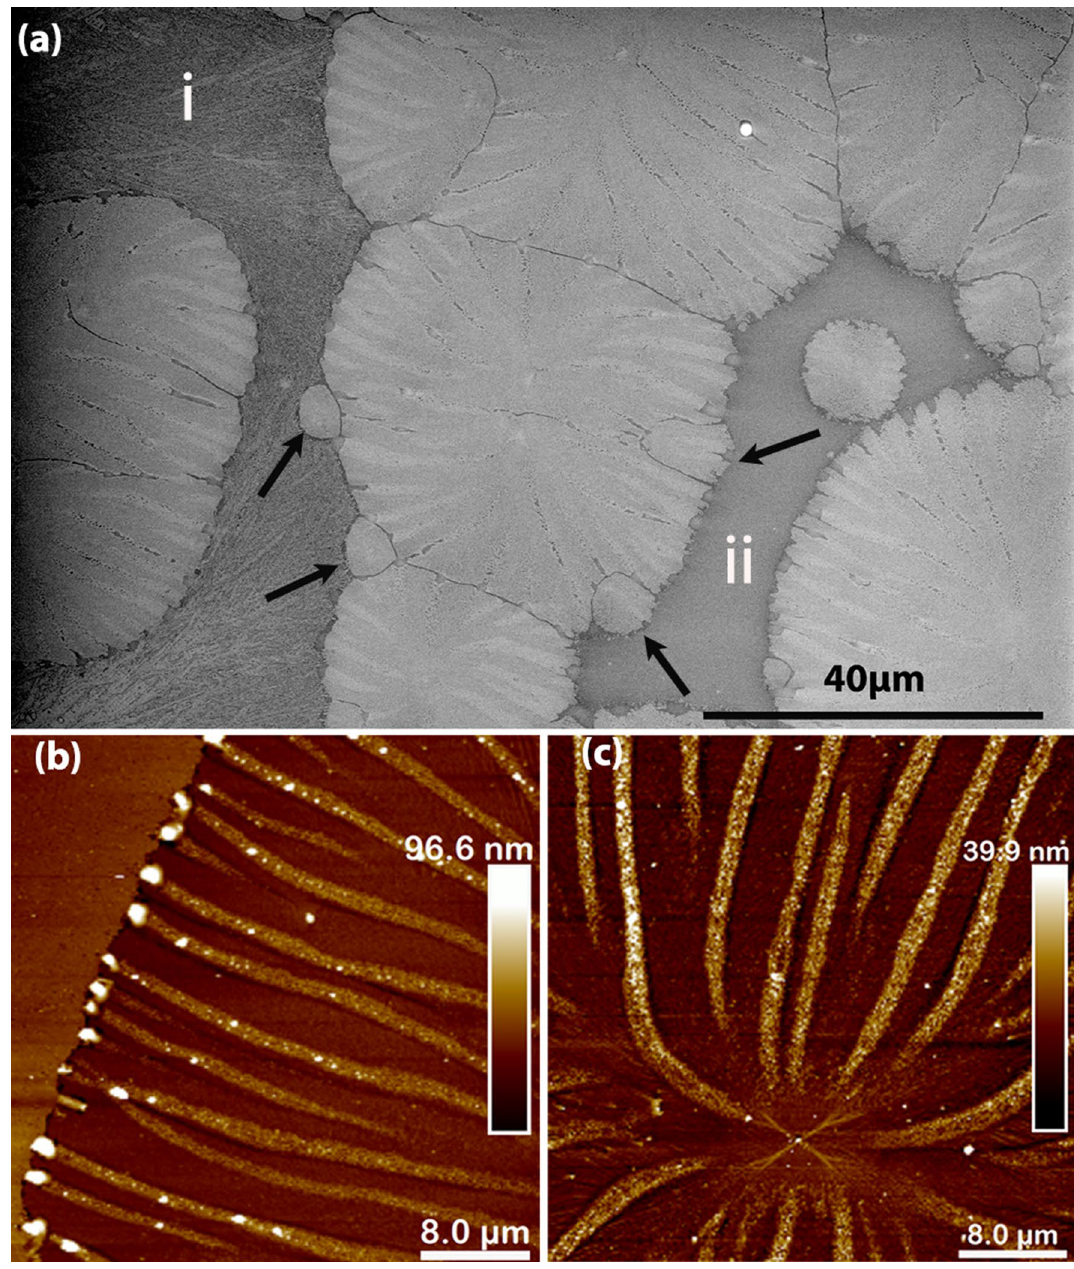
Figure 5. ( a ) SEM images of a Si 0.75 Ge 0.25 O 2 film grown on Y-cut quartz substrate shows the crystallization of domains surrounded by low crystallinity areas (i) and amorphous areas (ii). The black arrows point to the new domains nucleated at the edge of a bigger domain. ( b ) AFM image of a domain boundary where bumps are formed when the stripes meet the boundary. Notice the stripes are about 10 nm higher than the areas in between them. ( c ) AFM image showing the middle part of the domains with the nucleation point is a central point in area from which stripes